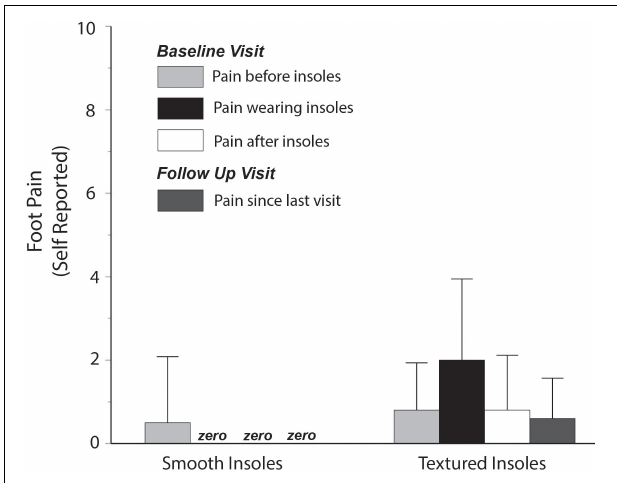
FIGURE 5 | Self-reported foot pain. Pain reported while wearing textured insoles was low, with an average rating of approximately 2 out of 10.